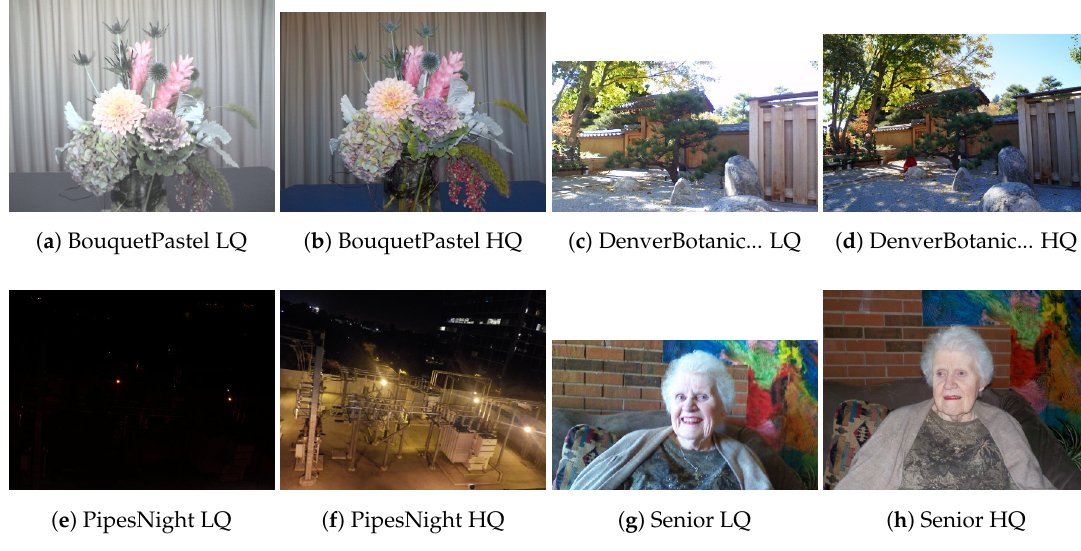
Figure 1. Sample of the CCRIQ2 scenes with Low Quality (LQ) and High Quality